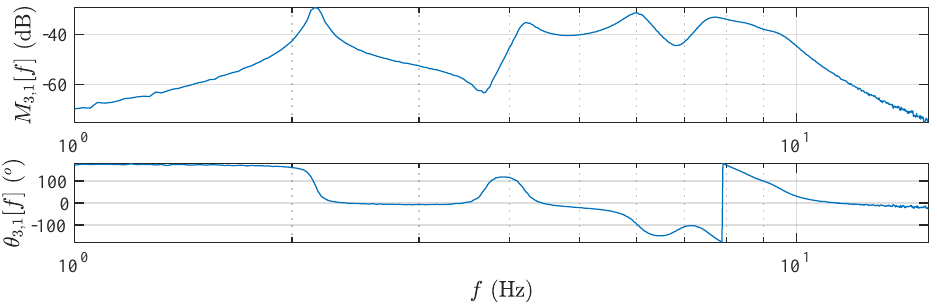
Figure 7. Spring-mass-damper: driving point FRF at reference